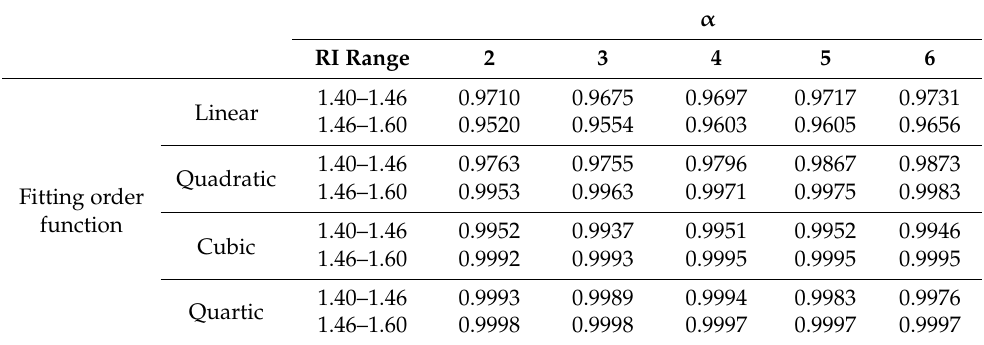
Table 3. R 2 error of the i-th degree fitting functions in relation to the α parameter used during the D-triangulation. α RI Range 2 3 4 5